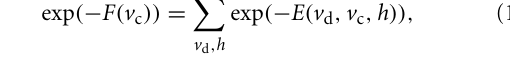
Table 1 | List of parameters used in the software simulations.